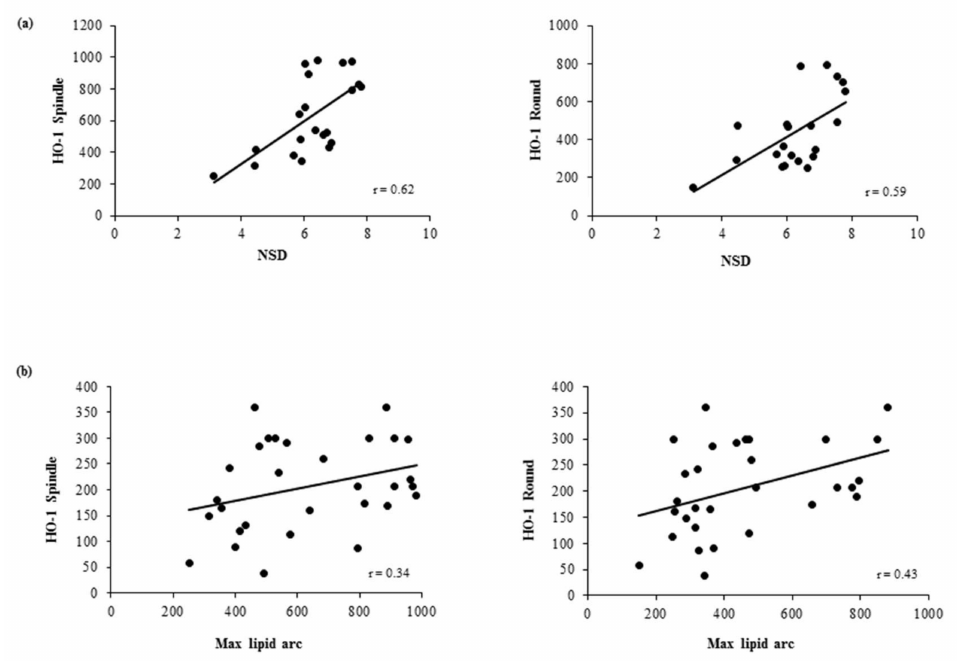
Figure 5. Correlations between in vivo plaque features and HO-1 levels in MDM morphotypes. Correlation between HO-1 levels in round and spindle MDMs and ( a ) macrophage content (NSD) and ( b ) max lipid arc, detected by means of OCT in in vivo